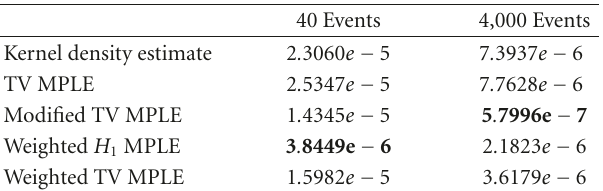
Table 2: This is the L 2 error comparison of the five methods for both the introductory example shown in Figure 1 and the sparse example shown in Figure 3. Our proposed methods performed better than both the Kernel Density Estimation method and the TV MPLE method.